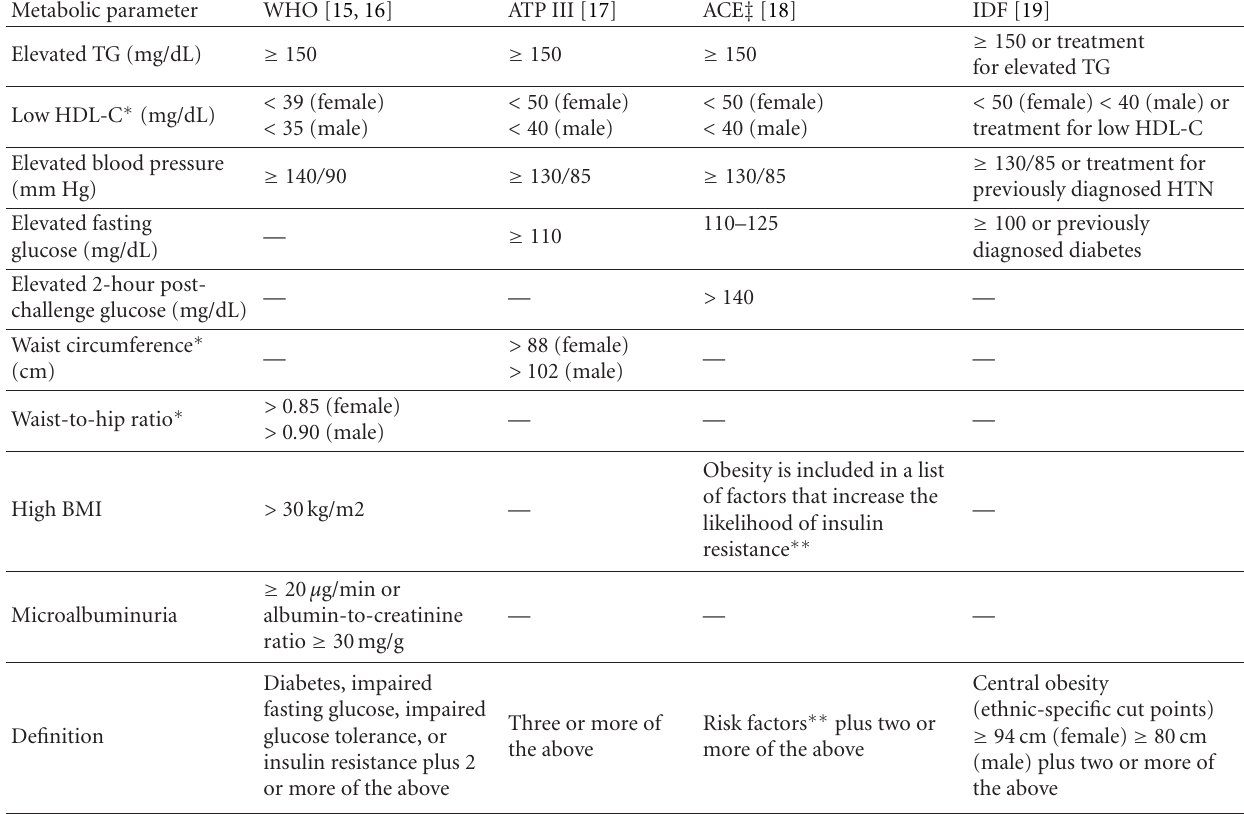
Table modified from [12, 21]. Abbreviations : WHO, World Health Organization; ATP III, National Cholesterol Education Program Adult Treatment Panel III; ACE, American College of Endocrinology; IDF, International Diabetes Federation; HTN, hypertension. ‡ ACE uses term “insulin resistance syndrome” ∗ Gender-specific parameters ∗∗ Risk factors include overweight (BMI > 25 kg/m2 or waist circumference > 40 inches for men and > 35inches for women), sedentary lifestyle, age > 40 years, non-Caucasian, family history of type 2 diabetes, hypertension, or cardiovascular disease, and personal history of polycystic ovarian syndrome, gestational diabetes, acanthosis nigricans, or nonalcoholic steatohepatitis. transcription. The N-terminal A/B region contains a ligand- independent transcriptional activation function (AF-1).